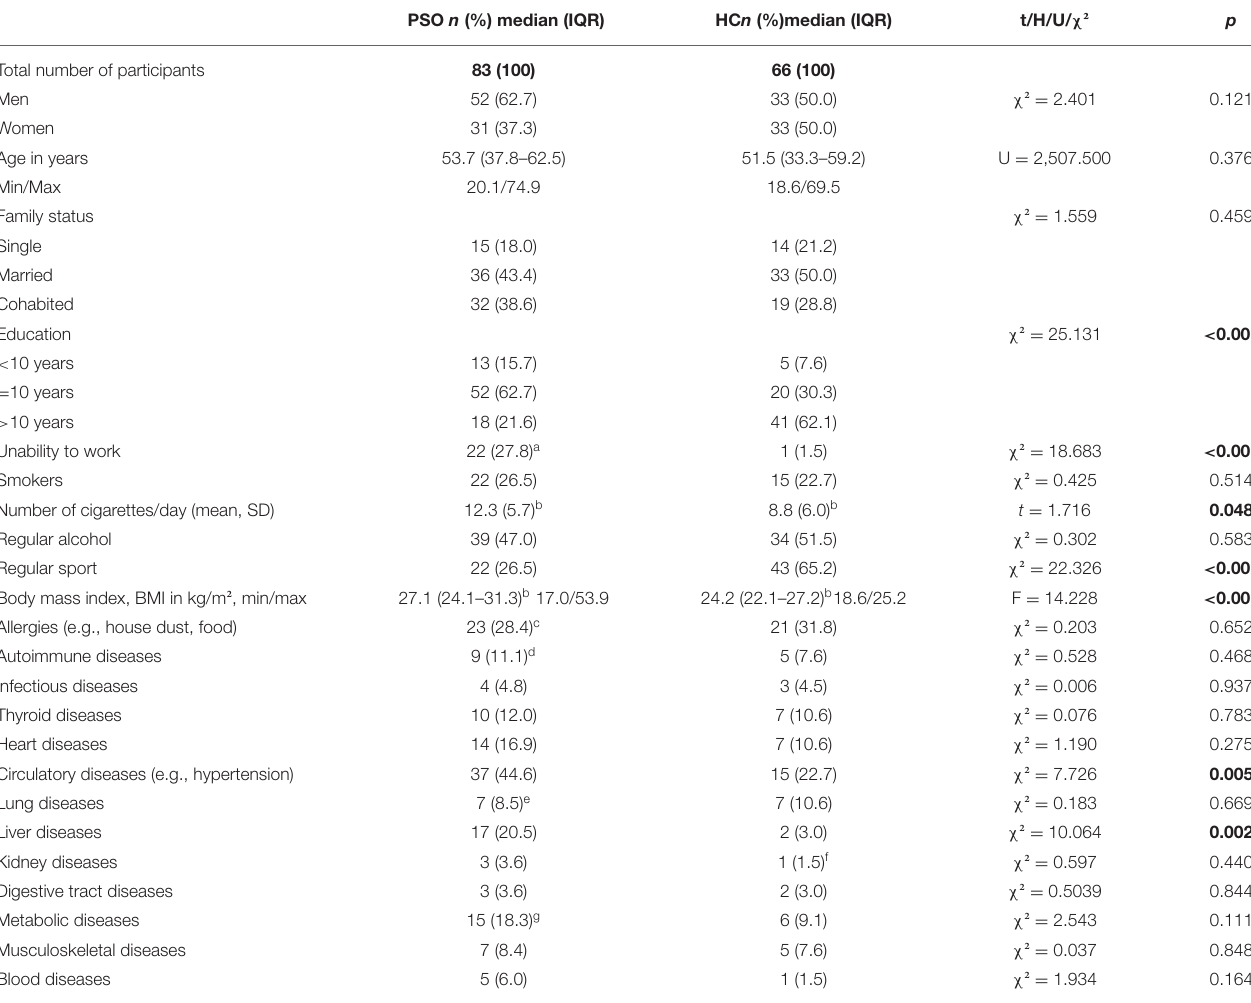
TABLE 1 | Characteristics of the sample of patients with psoriasis (PSO) and skin-healthy control group